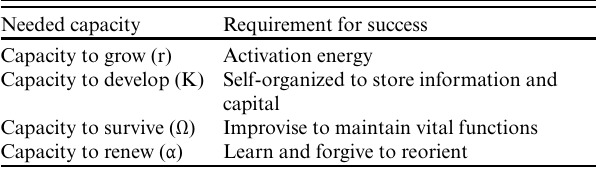
Table 1. Key features for the success of a system (entry